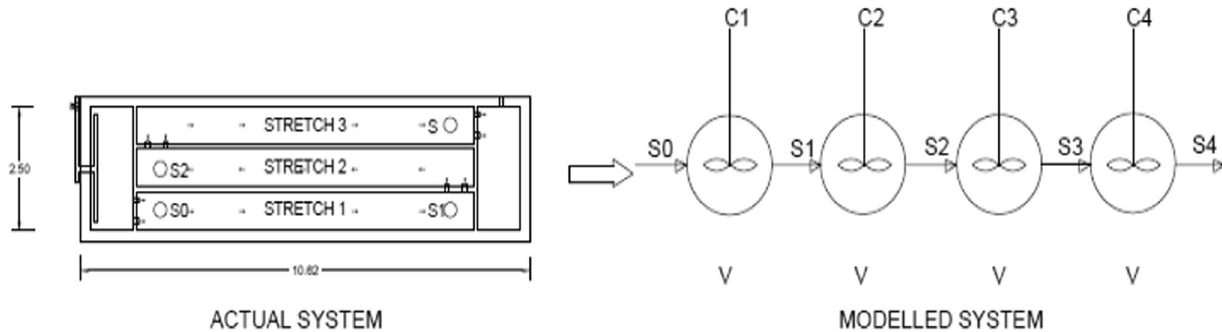
Fig. 3 Actual and modeled systems